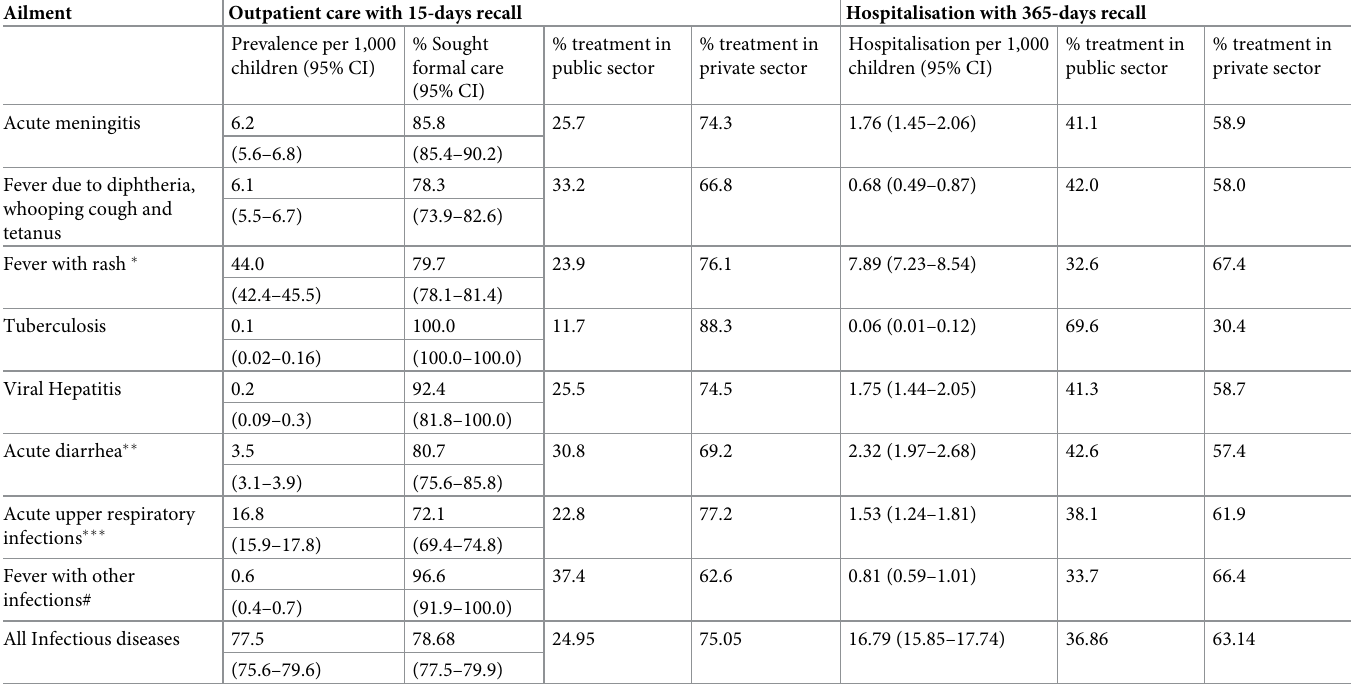
Table 1. Prevalence and healthcare consultation for childhood infections (age 0–5 years) in outpatient and hospital settings. Ailment Outpatient care with 15-days